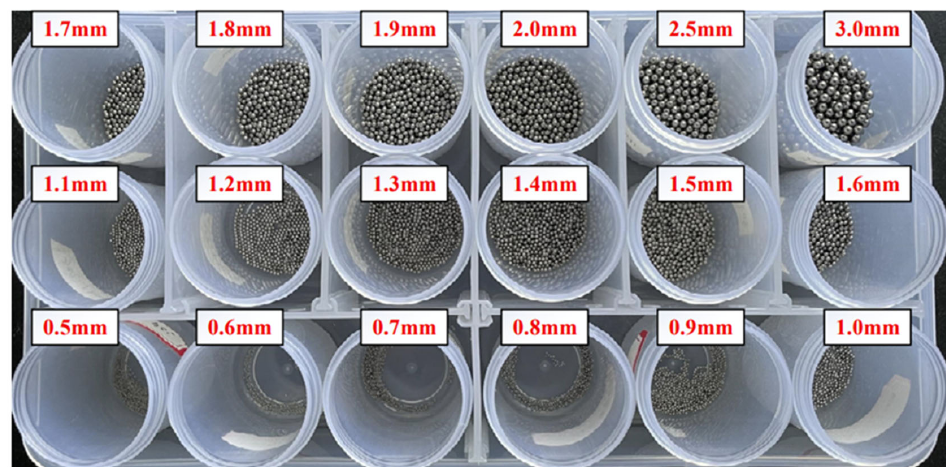
Table 7. Classification label of wear particles used in the experiment.